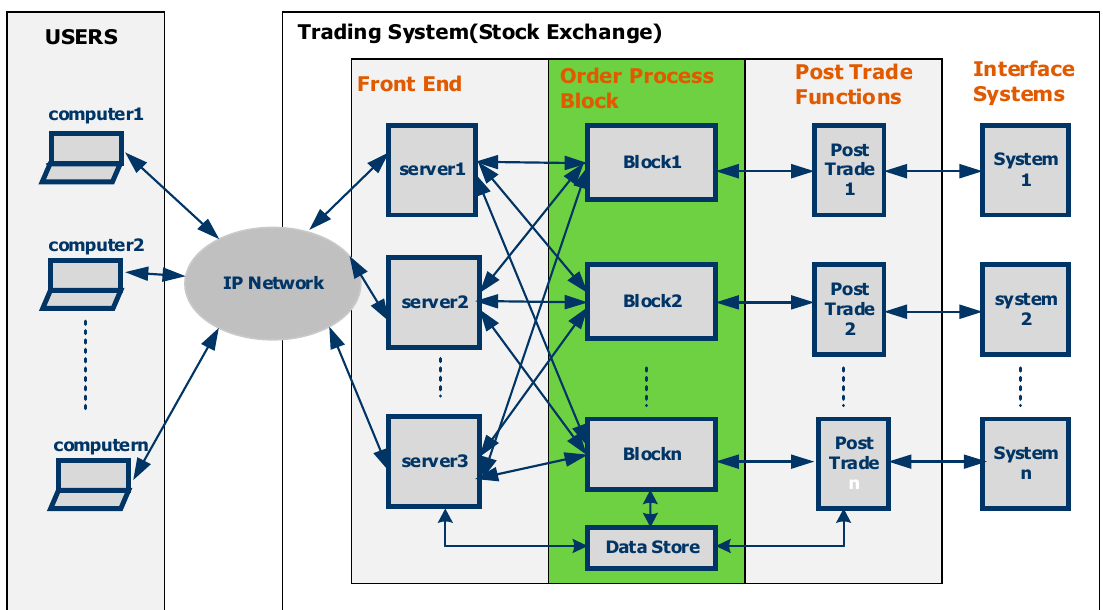
Figure 1. Trading system architecture (the block being accelerated is shown in green color) .